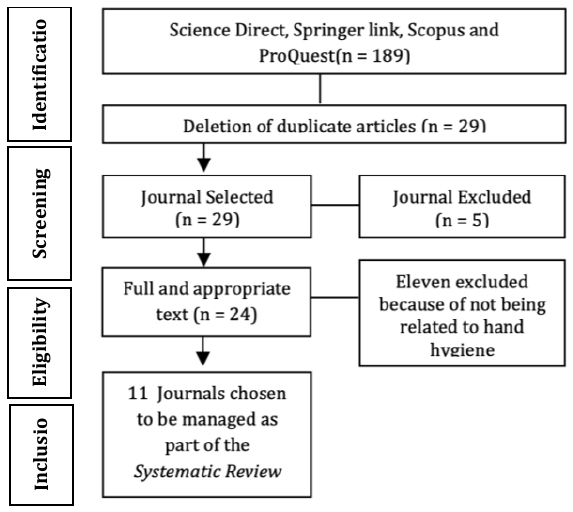
Figure 1. Literature Search